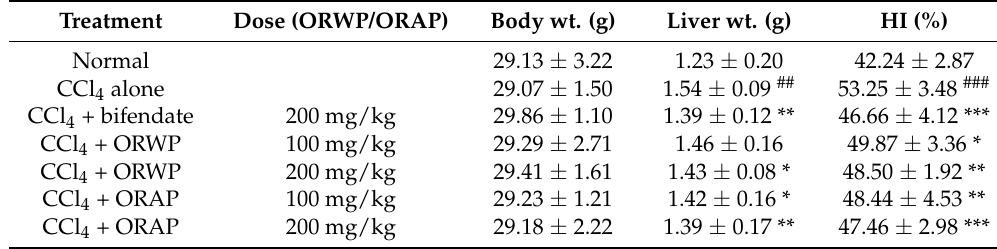
Table 2. Effects of ORWP and ORAP on body weight, liver weight and hepatosomatic index (HI) in CCl 4 -treated